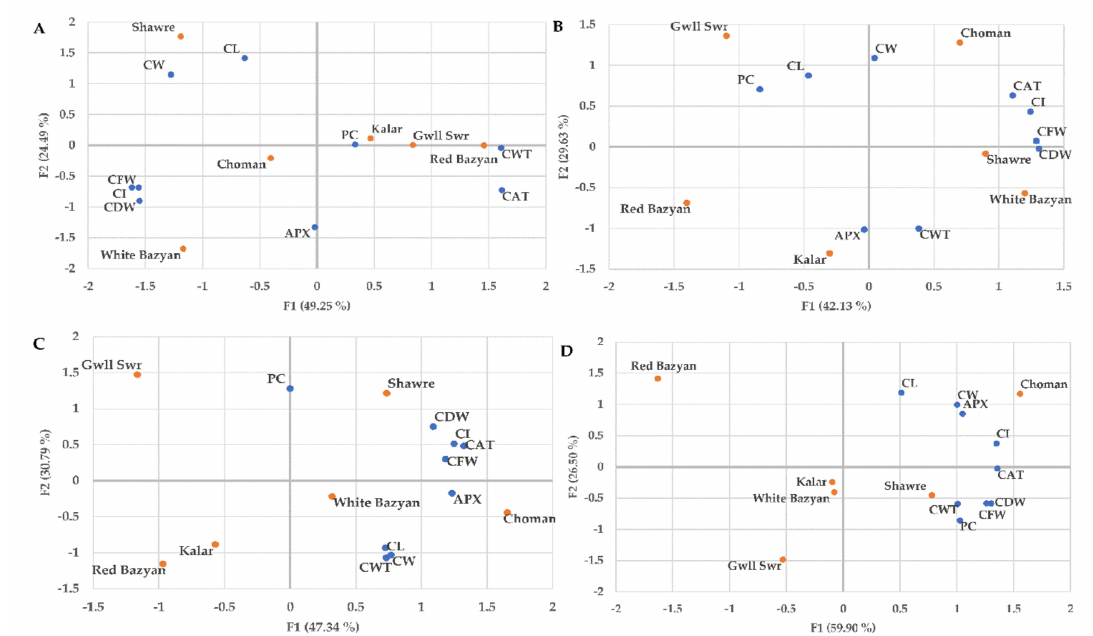
Figure 5. Principal component analysis (PCA) plot showing the distribution and relationship between rice genotypes and studied traits. ( A ). normal condition, ( B ). T0.50 stress, ( C ). T1.00 stress, and ( D ). T1.50 stress.